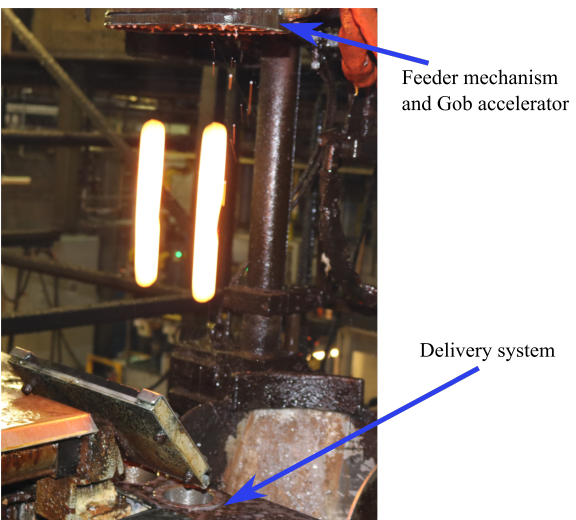
Figure 9. Free-falling glass gobs between Feeder mechanism and delivery